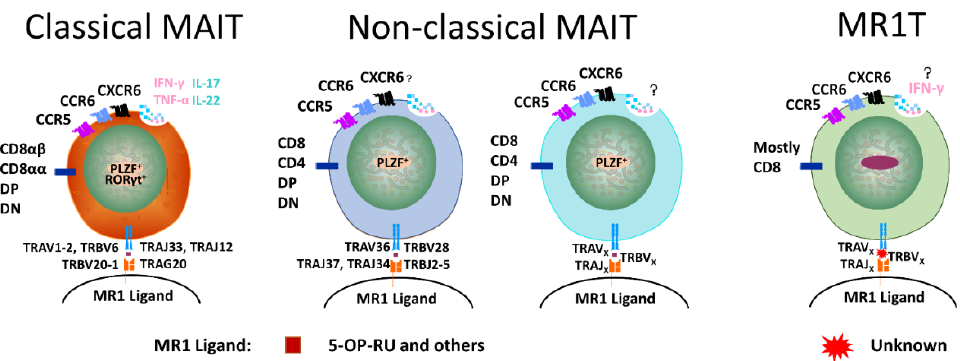
Figure 3. Main characteristics of subsets of human MR1-restricted T cells with αβ TCRs. Classical MAIT cells express TCRs with TRAV1-2 and PLZF. Non-classical MAIT cells express PLZF but not TCRs with TRAV1-2. Atypical MR-1 restricted T (MR1T) cells express Table 1. Main Characteristics of Subsets of Human MR1-restricted T cells.